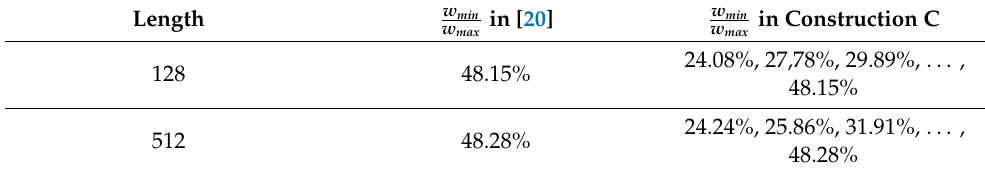
Table 4. Examples of the ratio between the minimum and the maximum weights from Construction